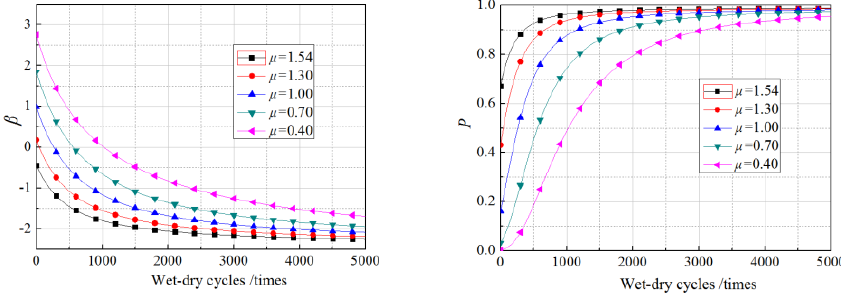
Figure 7. The effects of mean of the load on the 30% sustained loading specimens.